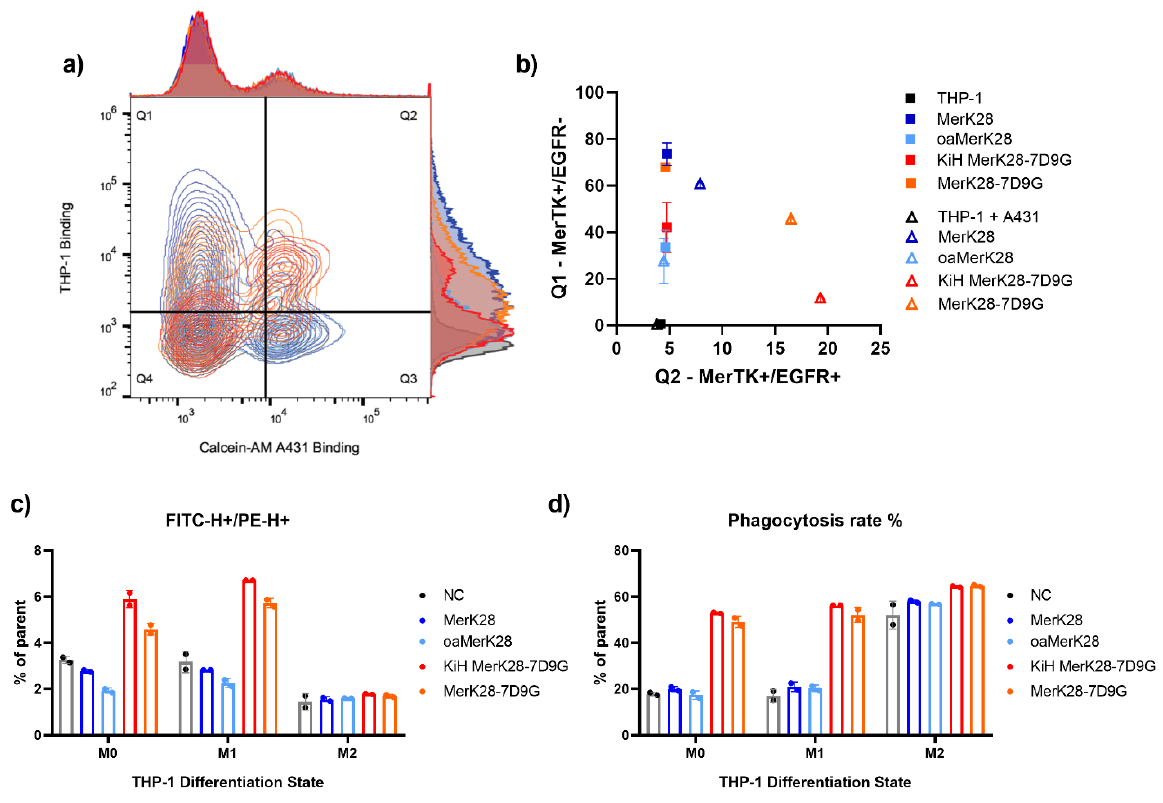
Figure 6. Macrophage-engagement and phagocytosis of tumour cells. ( a ) Contour plots of A431 binding on the x-axis (FITC fluorescence) and THP-1 binding on the y-axis (PE fluorescence) following the colour-coding of ( b ). Double-positive events in the upper-right Q2 quadrant show simultaneous engagement of THP-1 and A431 cells, whereas the upper-left Q1 quadrant represents MerTK-binding only. ( b ) Frequency of parent of Q1 and Q2 from ( a ). Coloured squares represent incubation of antibodies only on THP-1 cells, whereas the triangles represent co-incubation of pre-stained THP-1 cells and Calcein-AM-stained A431 cells. ( c ) Quantitation of CD14+-THP-1 cells and Calcein-AM red—orange stained A431 cells for phagocytosis assays. The negative control (NC) represents co-incubation of both cell types without antibody treatment. ( d ) Determination of phagocytosis rate (%) after co-incubation of THP-1 cells in different differentiation states together with A431 cells. Error bars represent the standard deviation of at least biological duplicates.